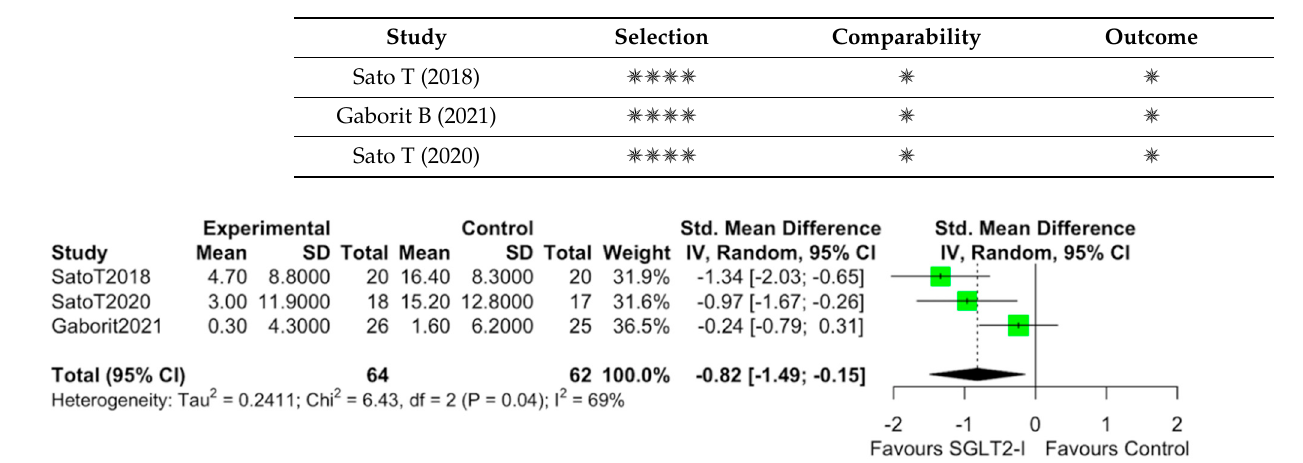
Table 2. Quality assessment (NOS).